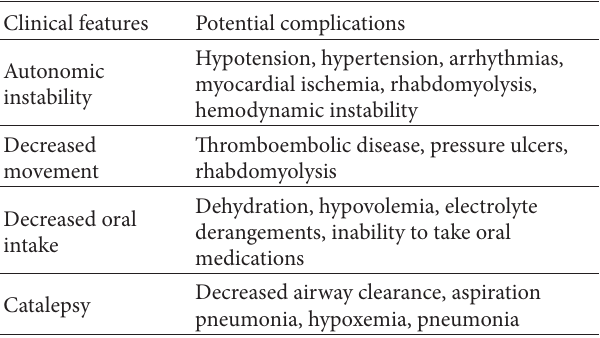
Table 1: Complications associated with patient’s clinical